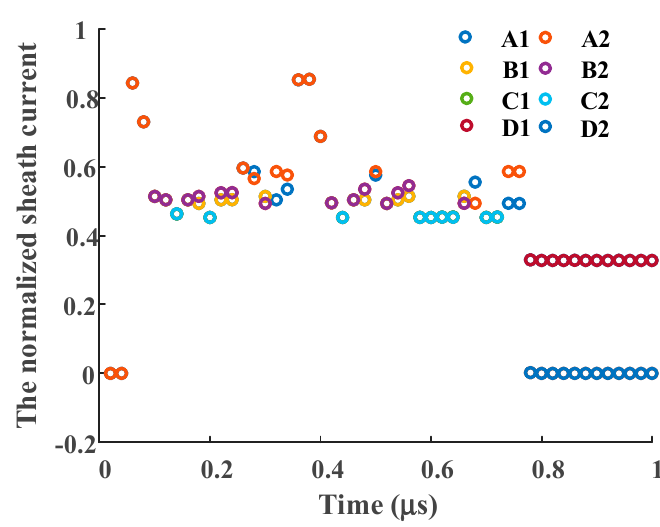
Figure 26. The scatter diagram of the clustering data of I L and I R .